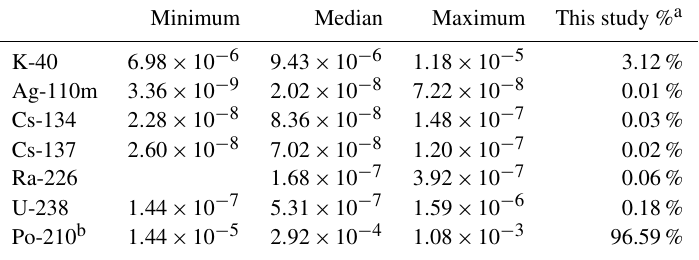
a CR: WB-M represents whole-body to muscle concentration ratios, WB-G represents whole-body to gut concentration ratios, and WB-W represents whole-body to water concentration ratios. b NA: data not available because radioactivity of specific radionuclides in at least one tissue was below the MDA. c Values for Cs-134 and Cs-137 were calculated using mean Cs-134 and Cs-137 seawater activity concentrations of 35.1 and 36.2Bqm − 3 , and the values for Ag-110m were calculated using the MDA of Ag-110m in seawater (0.22Bqm − 3 ). Table 3. Ingestion dose estimates for human consumers of the squid in this study (Svyr − 1 based on 20kg consumption of squid).